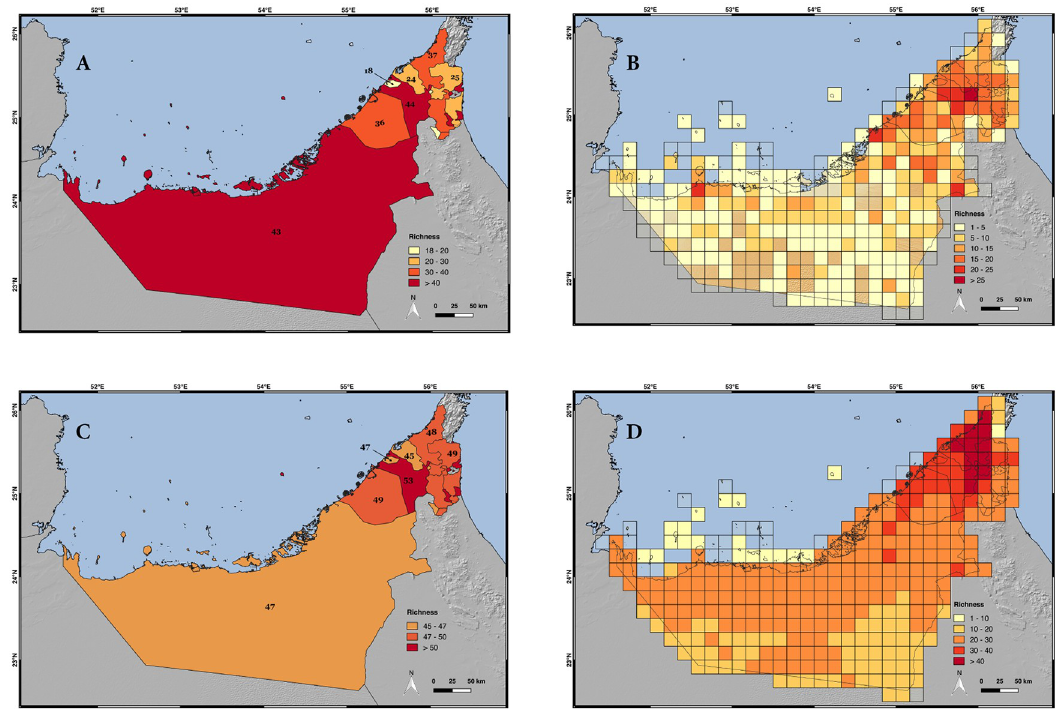
Fig 6. Species richness map of the UAE terrestrial reptiles. A) Species richness by emirate inferred with the occurrence point data; B) Species richness by 10 arc-minutes grid cells inferred with the occurrence point data; C) Species richness by emirate inferred with the species distribution models; D) Species richness by 10 arc-minutes grid cells inferred with the species distribution models. Only the 57 native species have been included in the analyses. Credits: OpenStreetMap contributors, SRTM.